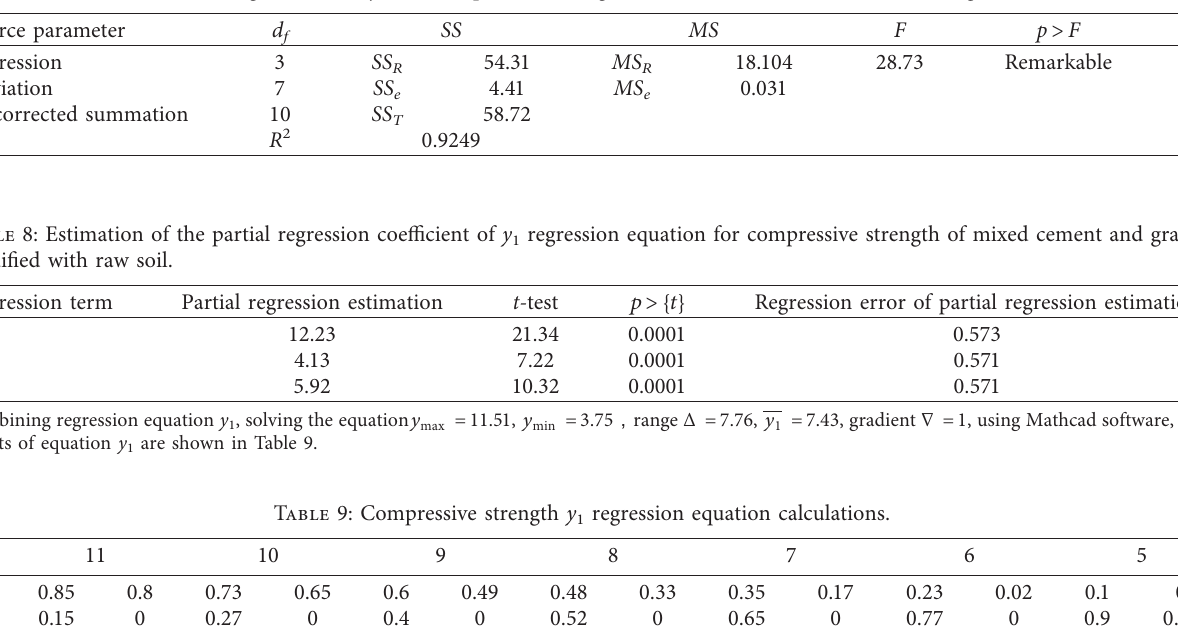
Table 7: Regression analysis of compressive strength of raw soil mixed with cement and gravel.